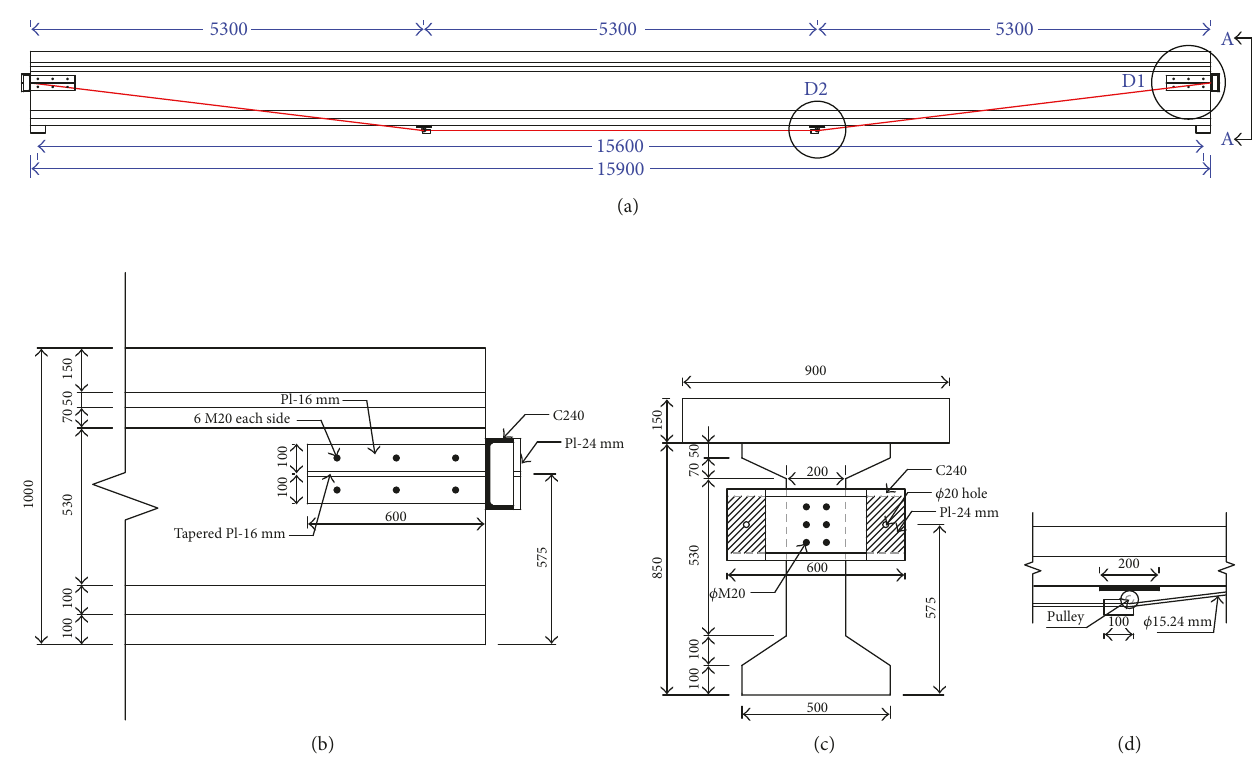
Figure 3: Strengthening technique details. (a) Longitudinal profile. (b) Detail D1 (anchor assembly). (c) View A-A. (d) Detail D2 (deviator).